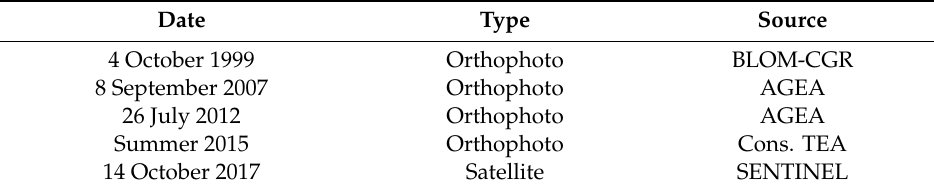
Table 3. Images used for glacier’s model